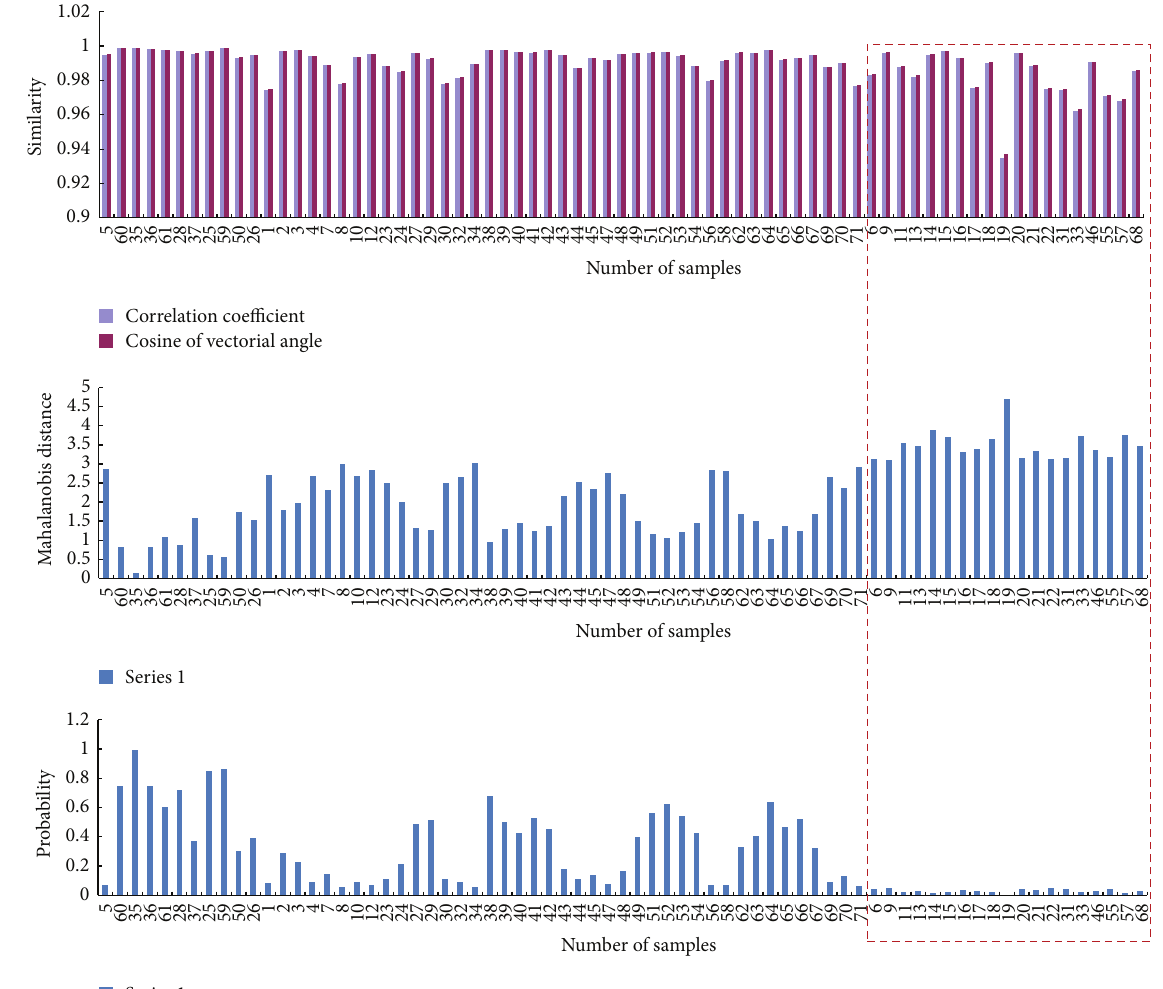
Figure 4: Similarities, Mahalanobis distances, and corresponding probabilities between the fingerprints of different batches of samples and the reference fingerprint. The fingerprints having significant differences to the reference fingerprint are shown in the red dotted box